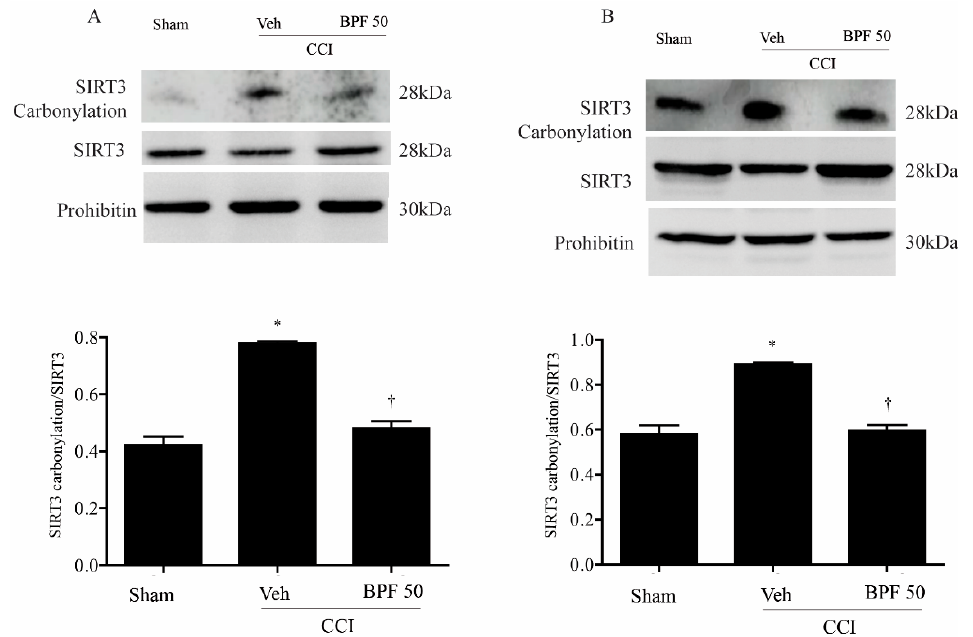
Figure 6. The development of hyperalgesia cause carbonylation of SIRT3 14 days post injury. Chronic constriction injury of the sciatic nerve (CCI) led to significant carbonylation of mitochondrial SIRT3 14 days ( A ) and 21 days ( B ) post injury, as measured by immunoprecipitation and Western blot. Infusion of BPF (50 mg / kg), concurrently with surgery (day 0), prevented SIRT3 carbonylation. In these conditions, prohibitin expression was statistically the same among the lanes. Gels are representative of results from 6 animals. Densitometric analyses of all animals per groups are reported. SIRT3 and SIRT3 carbonylation were first normalized with prohibitin and then these values were used to obtain carbonylation / total SIRT3 ratio. Results are expressed as mean ± SEM for 6 rats. * p < 0.05 compared to sham; † p < 0.05 compared to vehicle +